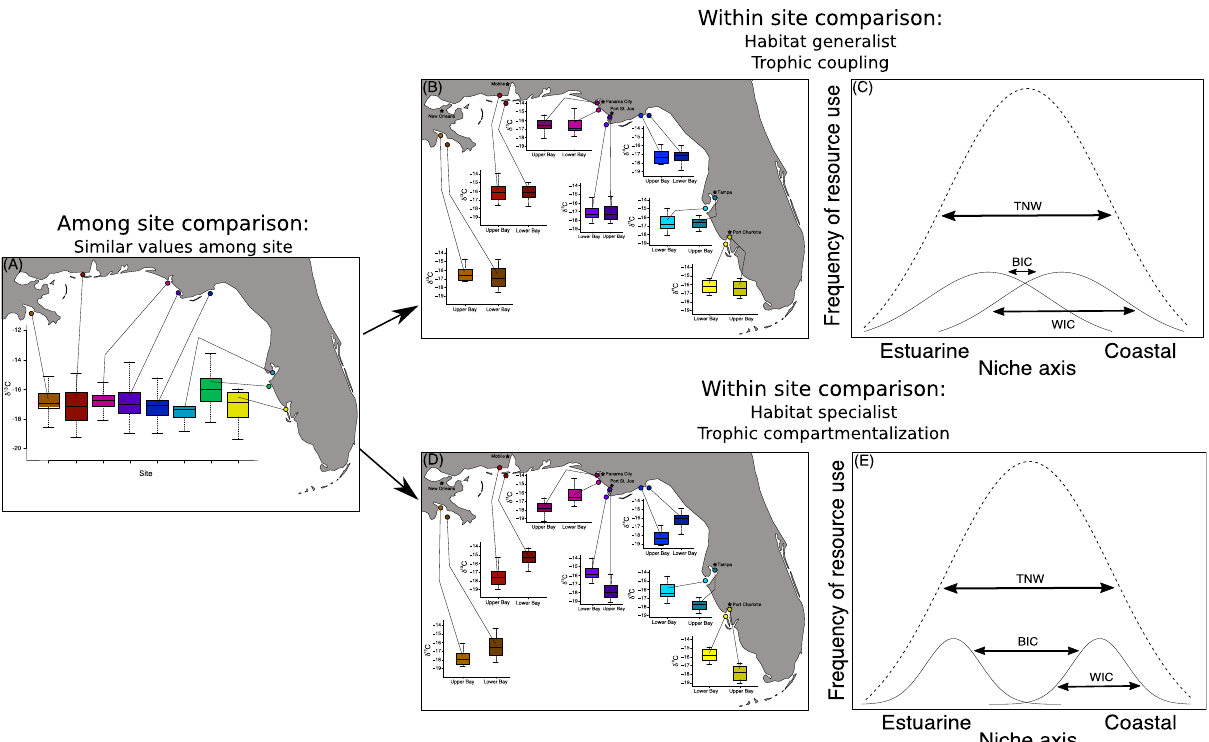
Figure 1. Hypothetical model depicting when isotopic values among sites are similar ( A ) and two scenarios of corresponding within-site patterns that can occur due to trophic coupling ( B , C ) or compartmentalization ( D , E ). In ( B ) dolphins sampled within and outside bays and sounds have similar, intermediate isotope values, indicating individuals use both estuarine and nearshore, marine habitats. ( C ) Individual dolphins have broad niches and the within-individual component (WIC) comprises most of the total niche width (TNW), indicating trophic coupling of habitats. In ( D ) dolphins sampled within and outside bays and sounds have different isotopic values, indicating individual dolphins use either estuarine or nearshore, marine habitats. ( E ) Individuals have narrow niches and the between-individual component (BIC) comprises most of the TNW, indicating dolphins maintain trophic compartments between habitats. Maps were generated using the ggmap package (version 3.0.0) in R 106 .